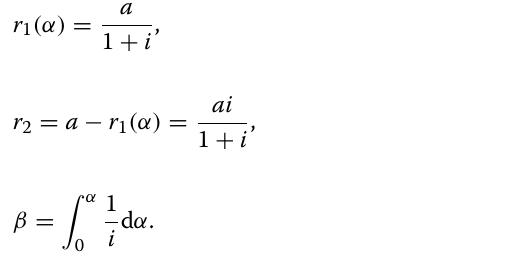
ratio curve (the thick line shown in Figure 5) of the asym- symmetry characteristic. Moreover, it is not possible to directly calculate the gear-pitch curves by using the equa- tions mentioned above. To obtain the gear-pitch curve,